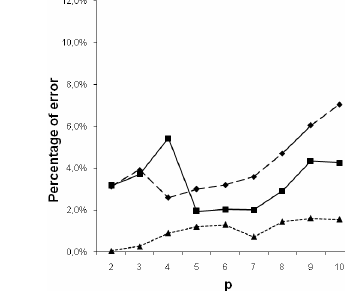
Figure 5. Optimality error for 30 aggregated nodes .